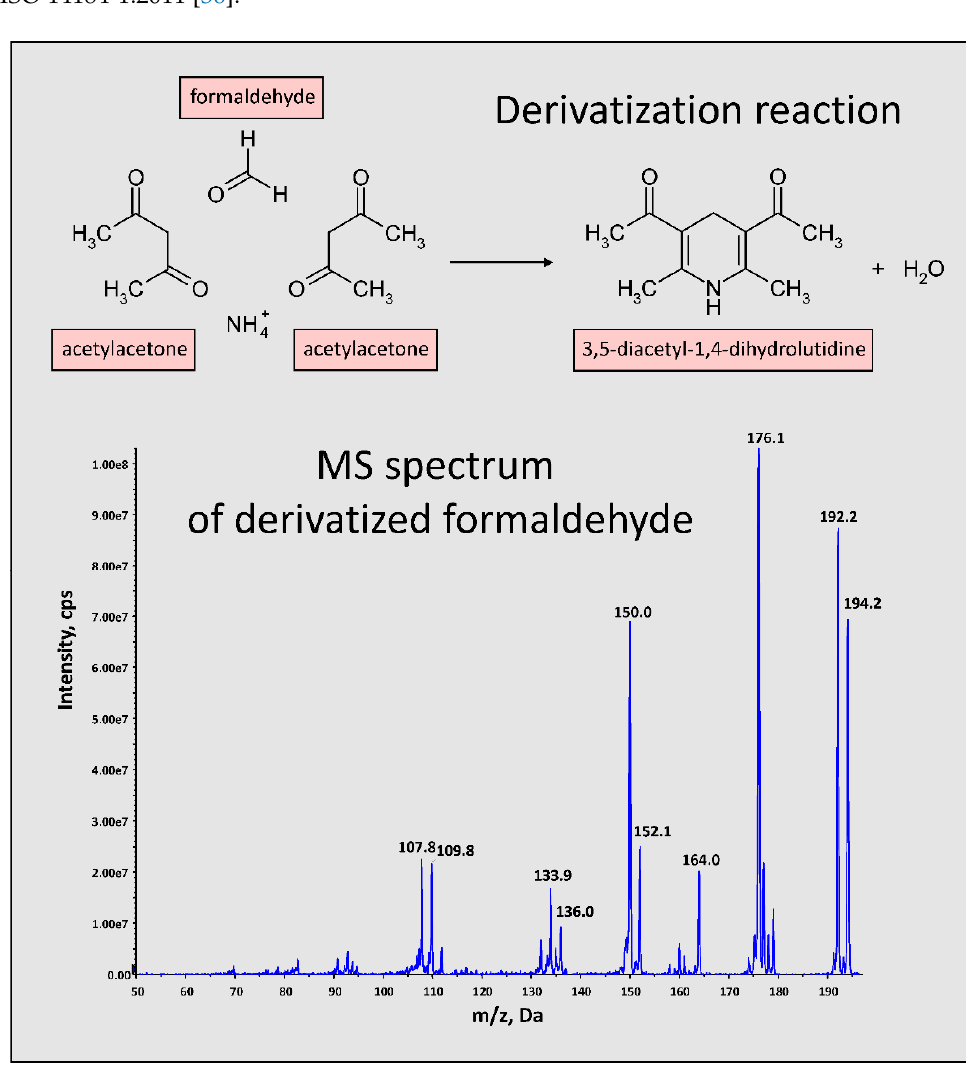
Figure 2. The Hantzsch reaction between Nash reagent and formaldehyde and the mass spectrum of 3,5-diacetyl-1,4-dihydrolutidine formed in the reaction.